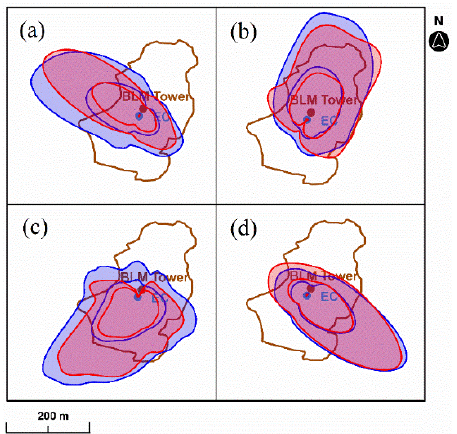
Figure 3. Flux footprint of each direction, estimated by the Flux Footprint Prediction model of Kljun et al. [28]. The red and blue coverage areas are flux footprints for unstable and stable conditions, respectively, and the two contours of each footprint indicate 80% and 90% flux of the contributing source area. ( a ) NW direction; ( b ) NE direction; ( c ) SW direction; ( d ) SE direction.